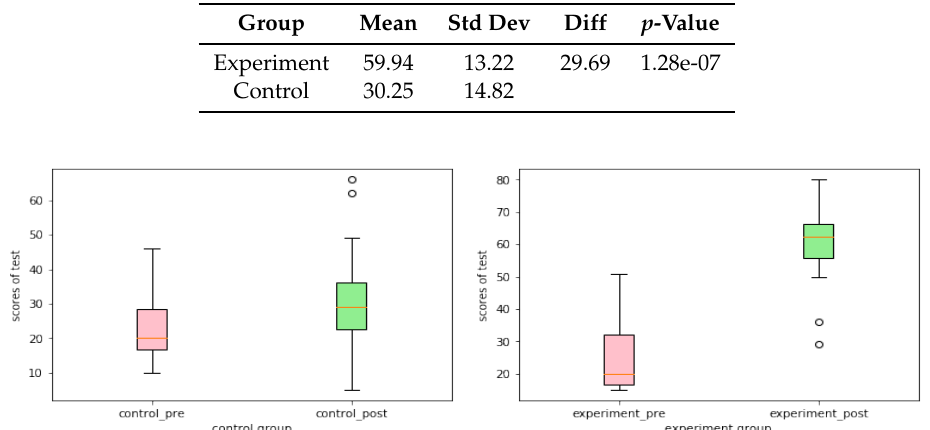
Table 4. The t -test analysis result of post-test scores of students in the control and experiment group.